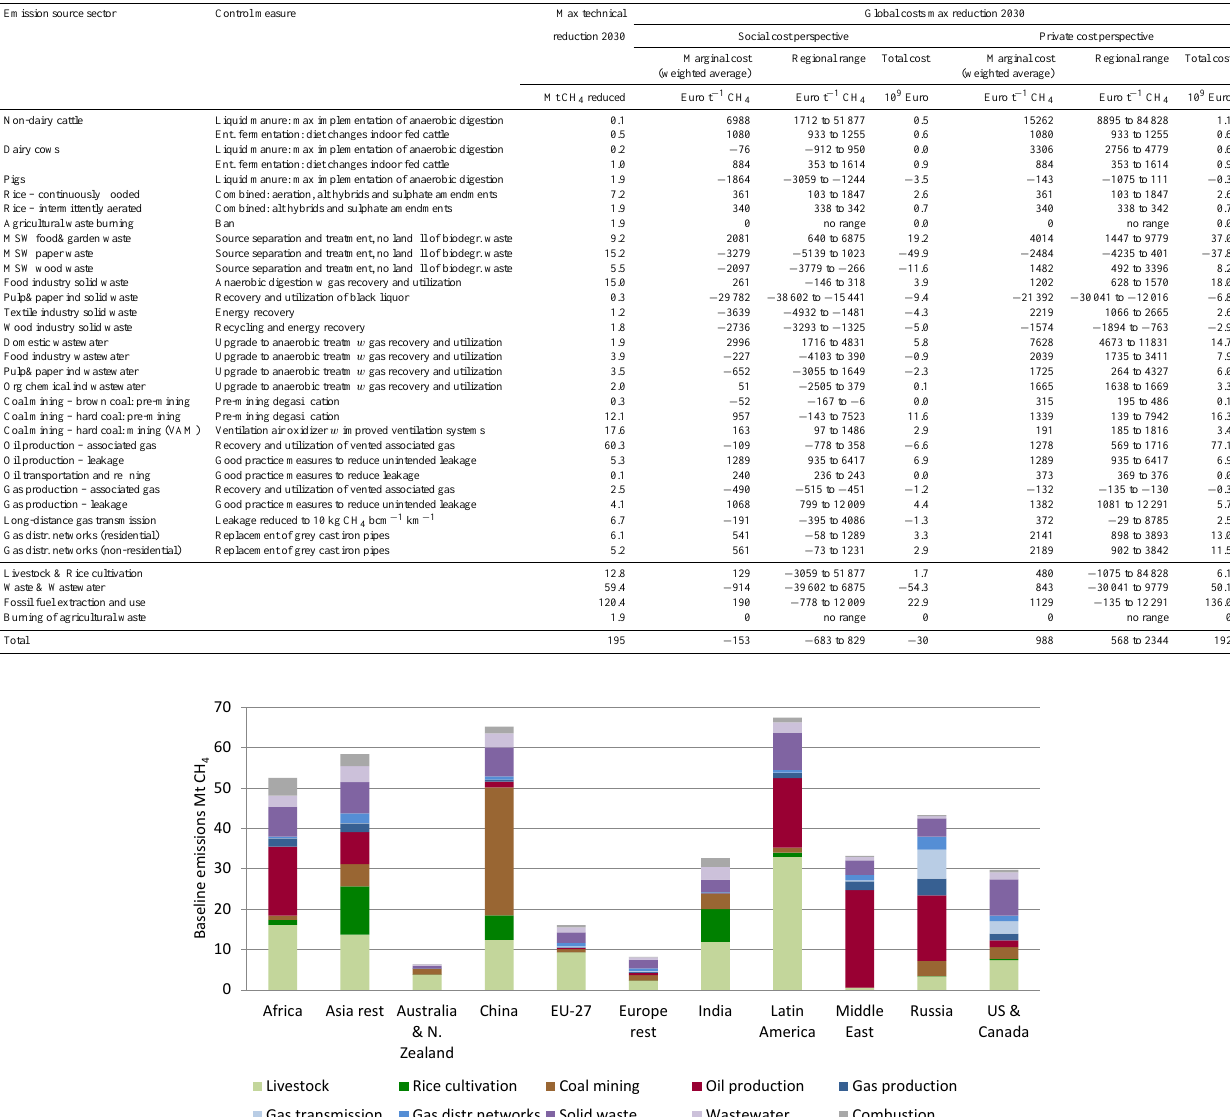
Table 7. Costs for global CH 4 technical mitigation potentials when estimated from social and private cost perspectives.